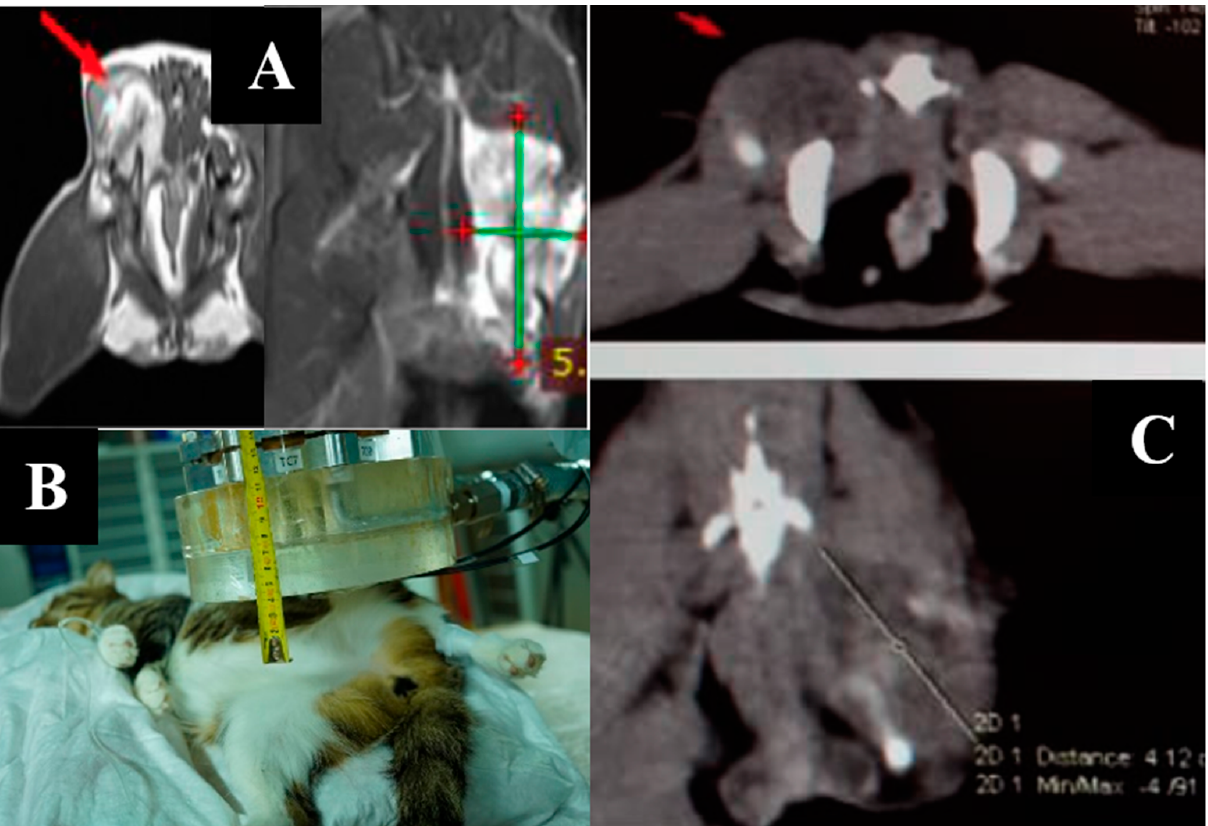
Figure 7. A cat named “Seledka”. ( A )—MRI of soft tissues before irradiation. ( B )—positioning of the animal during the irradiation session. ( C )—CT of soft tissues three weeks after irradiation.